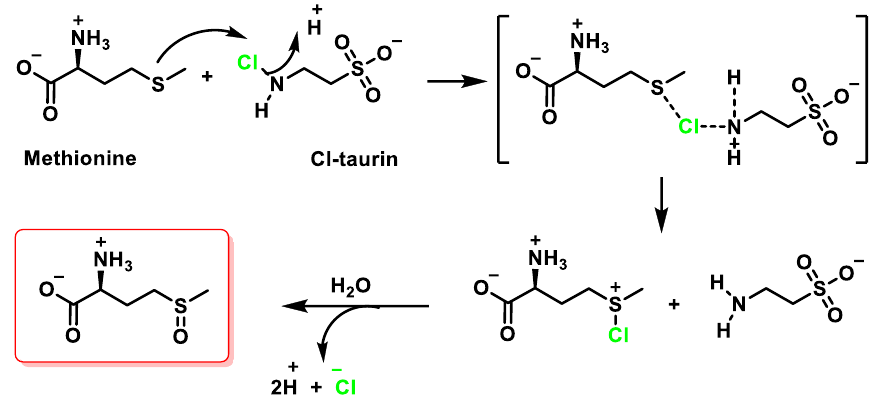
Figure 32. Mechanism of Met oxidation mediated by Cl – taurine to yield methionine sulfoxide. Proteins, the most abundant cellular molecules, are the main target of HOCl. In this context, sulphur-containing compounds such as cysteine, methionine and glutathione have the highest degree of reactivity with HOCl compared to other biological molecules.